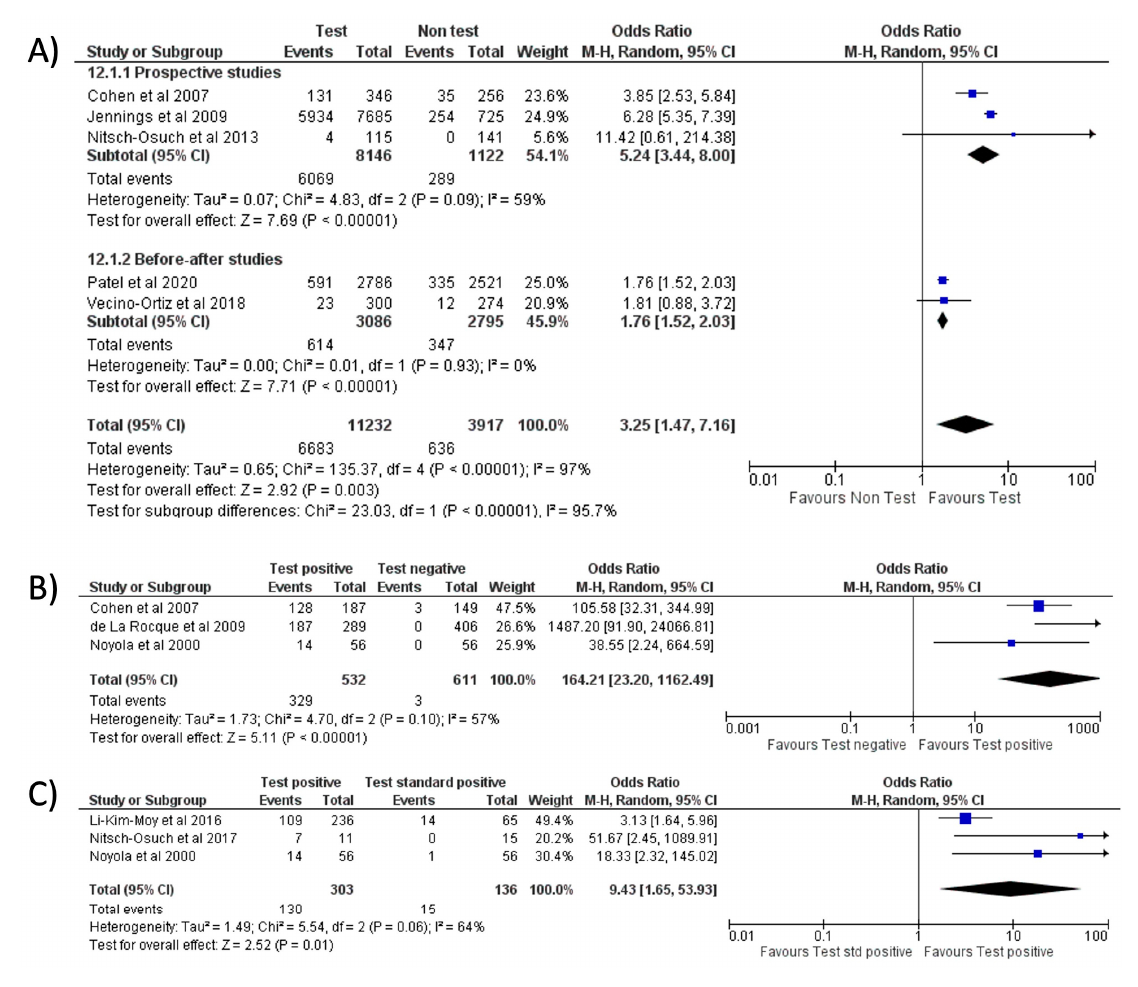
Figure 7. Forest plot of prescription of oseltamivir after implementation of RIDT: ( A ) RIDT vs. clinical diagnosis; ( B ) RIDT positive vs. RIDT negative; ( C ) RIDT positive vs. standard of care positive.